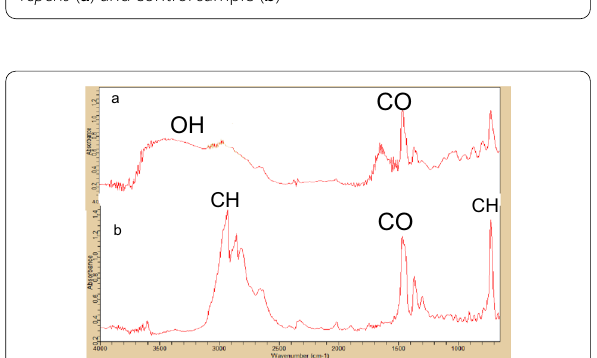
Fig. 5 Infrared peaks of polyethylene sample cultured with Eurotium repens ( a ) and control sample ( b )